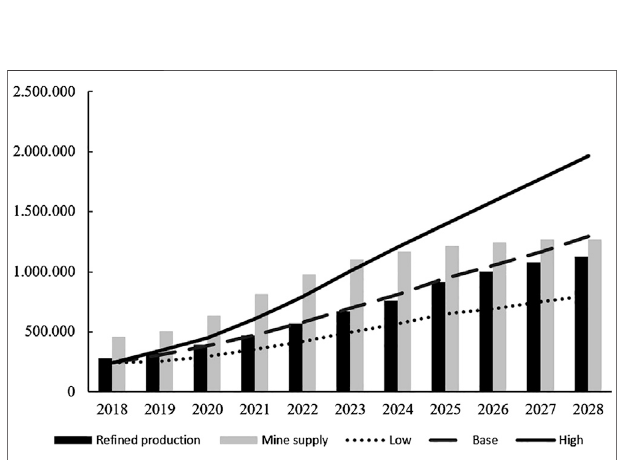
FIGURE 5 | Lithium market balance 2018 – 2028: base, low, high case demand (LCE t). Data are redrawn from Ref. Roskill (2019).